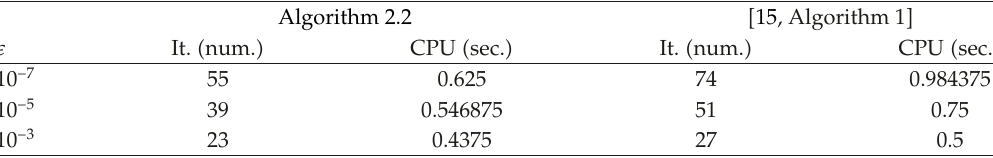
Table 1: Example 4.1. Algorithm 2.2